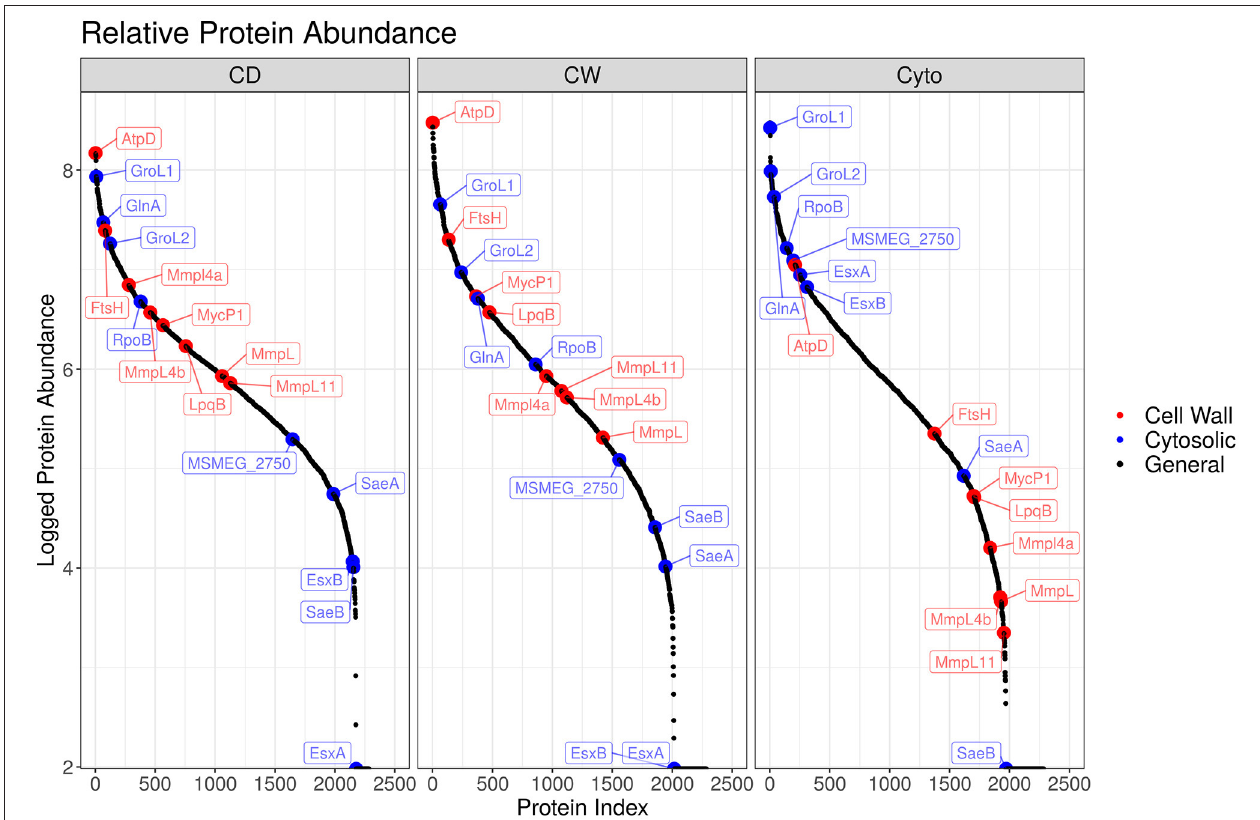
FIGURE 4 | Enrichment efficacy for SL bacteria. Ordered plot of proteins and their iBAQ abundance. Red points indicate known cell wall markers and blue cytosolic. A clear enrichment in the relative abundance of cell wall proteins within the cell wall and cell debris fractions over that observed in the cytosolic fraction is